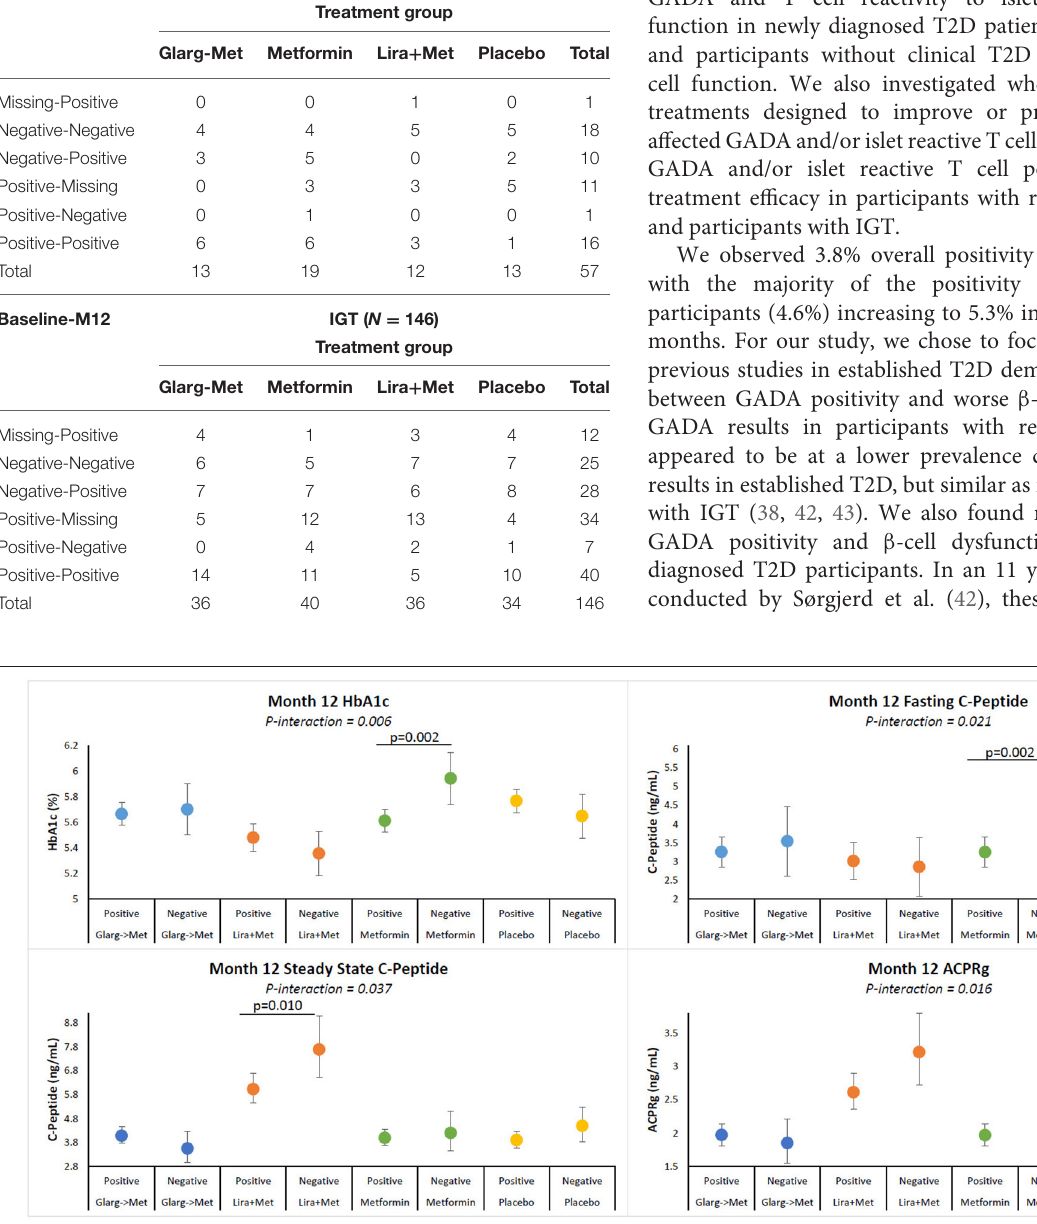
Frontiers in Immunology |